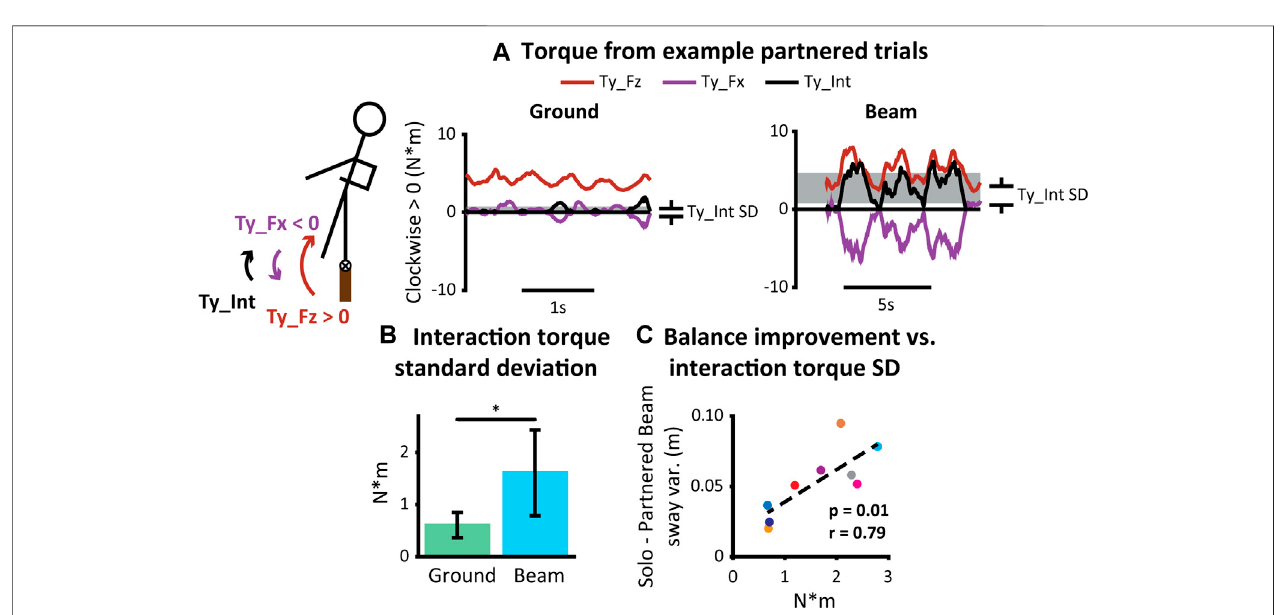
FIGURE6| Interactiontorquesduringpartneredwalking.* t -test p < 0.05.Errorbarsrepresent ± onestandarddeviation. (A) Interactiontorque,theoverlappingand opposingtorqueduetolateral(Ty_Fx)andvertical(Ty_Fz)handforces,duringpartneredbeam-walkingwereoscillatoryoverthecourseofatrial.Standarddeviationwas calculatedtoquantifymagnitudeofinteractiontorque. (B) Interactiontorquewashigherduringpartneredbeam-walkingthanpartneredovergroundwalking. (C) Greater interaction torque standard deviation correlated with greater improvement in balance performance. A different color dot denotes each partnership.